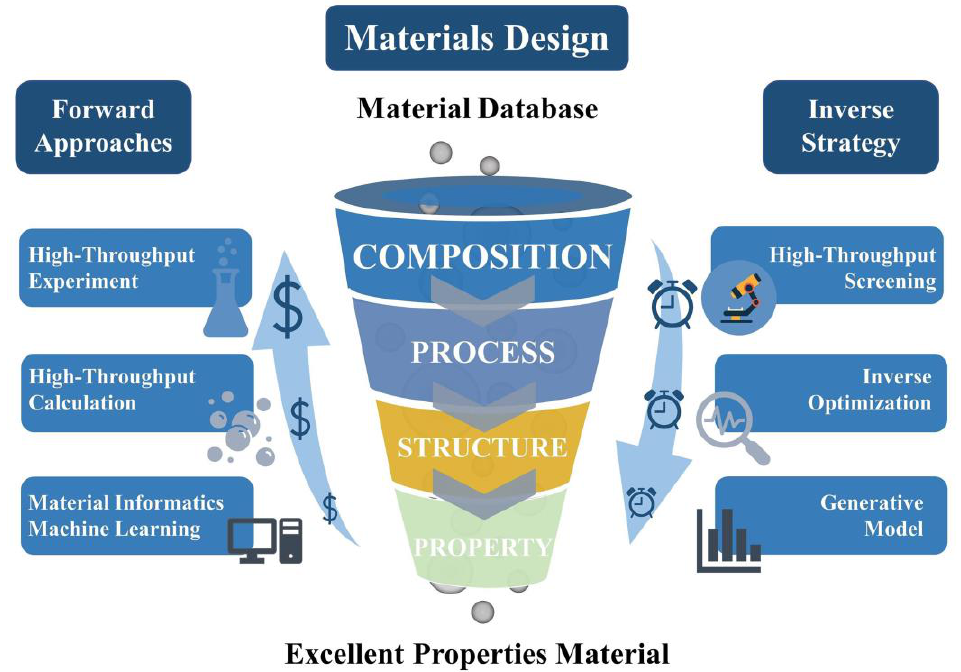
Figure 18. Facing ML to enhance material innovation and development based on bidirectional strat-